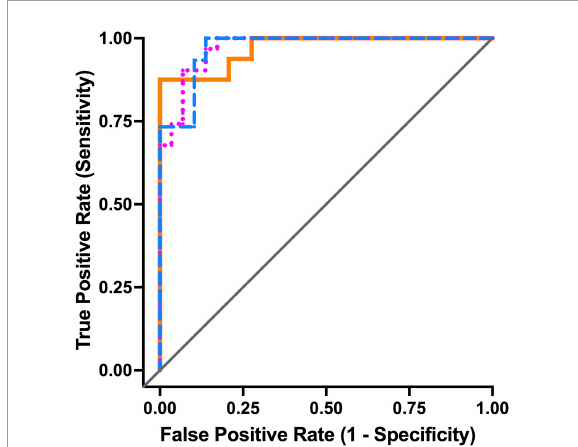
FIGURE2 Receiver operating characteristic curve analyses for the top three models. In the comparison CN vs. MCI (blue dashed line), AUC = 0.97 and top model is base model with SFN ( µ g/mL) and total protein ( µ g/mL), accuracy = 91%. For CN vs. AD (orange solid line), AUC = 0.97 and top model is base model with CST-C (total protein ratio) and IL-1RN (total protein ratio), accuracy = 96%. For CN vs. combined MCI/AD (pink dotted line), AUC = 0.97 and top model is base model with CST-C (total protein ratio), IL-1RN (total protein ratio), MMP-9 (total protein ratio) and total protein ( µ g/mL), accuracy = 92%. AD, Alzheimer’s disease; CN, Cognitively Normal; CST-C, Cystatin-C; IL-1RN, Interleukin-1 receptor antagonist protein; Matrix metalloproteinase 9, MMP-9; MCI, Mild cognitive impairment; SFN,